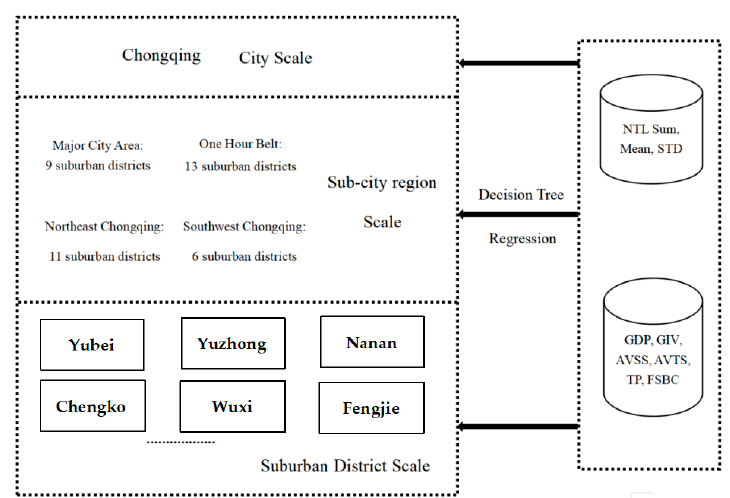
Figure 5. Framework for the multi-scale decision tree regression